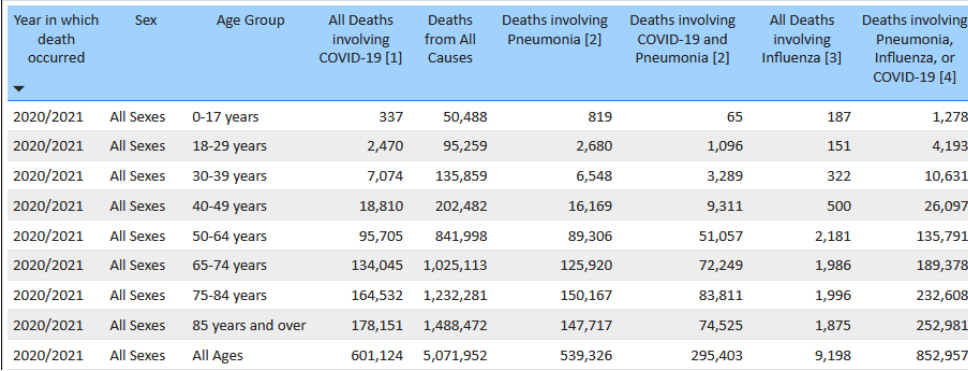
Figure A2. COVID-19 death statistics by age [CDC, 22 July